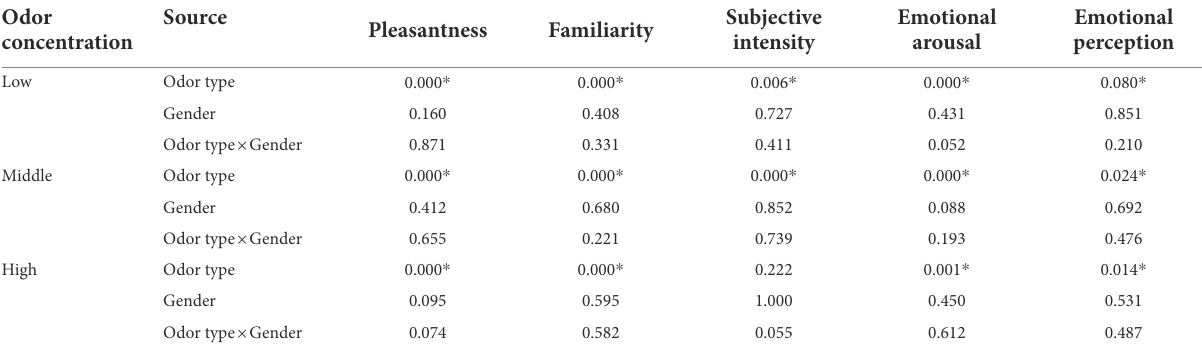
TABLE 7 The significance of the indicators under main effect and interaction of gender and